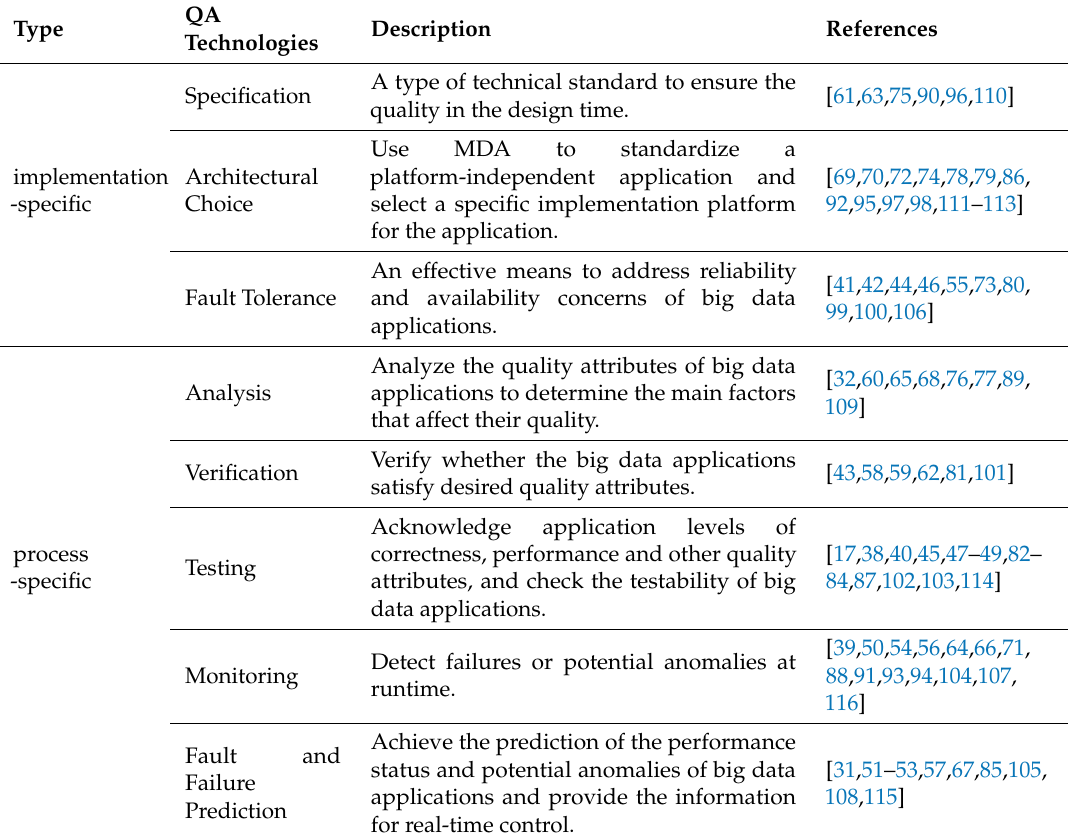
Table 10. Identified QA